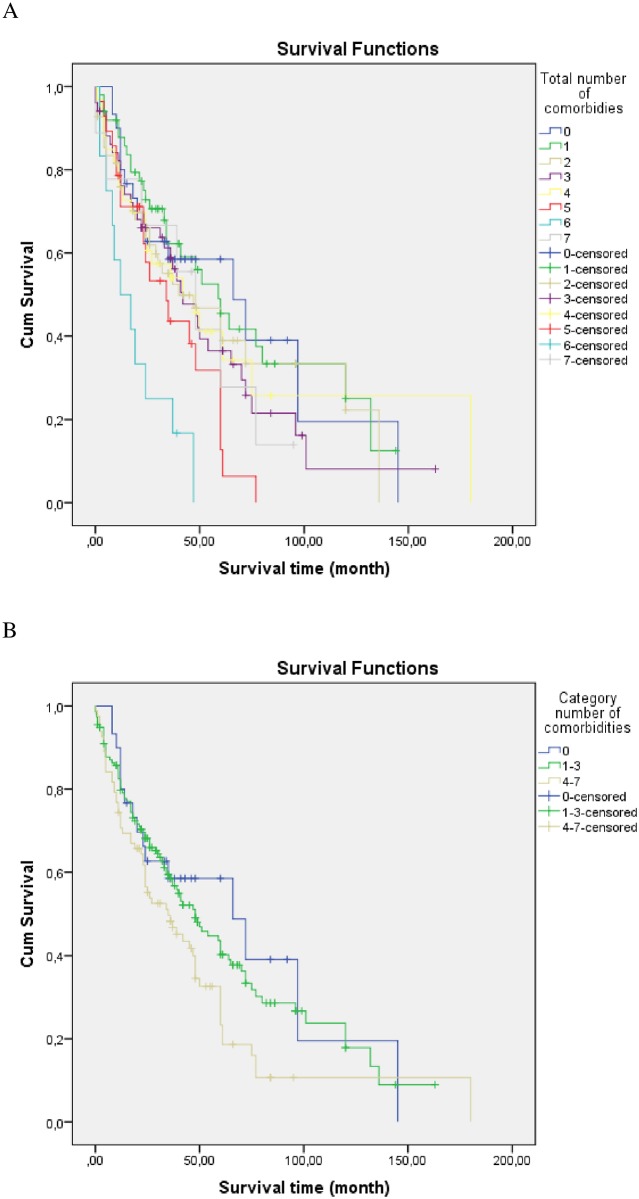
(A) Kaplan-Meier survival curves as a function of the total number of comorbidities. Survival duration decreased as a function of the number of comorbidities (p = 0.004): median survival of 66, 59, 40, 42, 42, 34, 12 months for 0, 1, 2, 3, 4, 5 and 6 comorbidities, respectively. The number of patients with 7 comorbidities was too low (N = 9) to correctly evaluate survival. (B) Kaplan-Meier survival curves as a function of the number of comorbidities clustered in three categories (0, 1–3, 4–7). Survival duration decreased significantly as a function of the number of comorbidities (p = 0.047): 0 comorbidity (N = 30; median survival 66 months), 1–3 comorbidities (N = 156; median survival 48 months) and 4–7 comorbidities (N = 82; median survival 35 months).